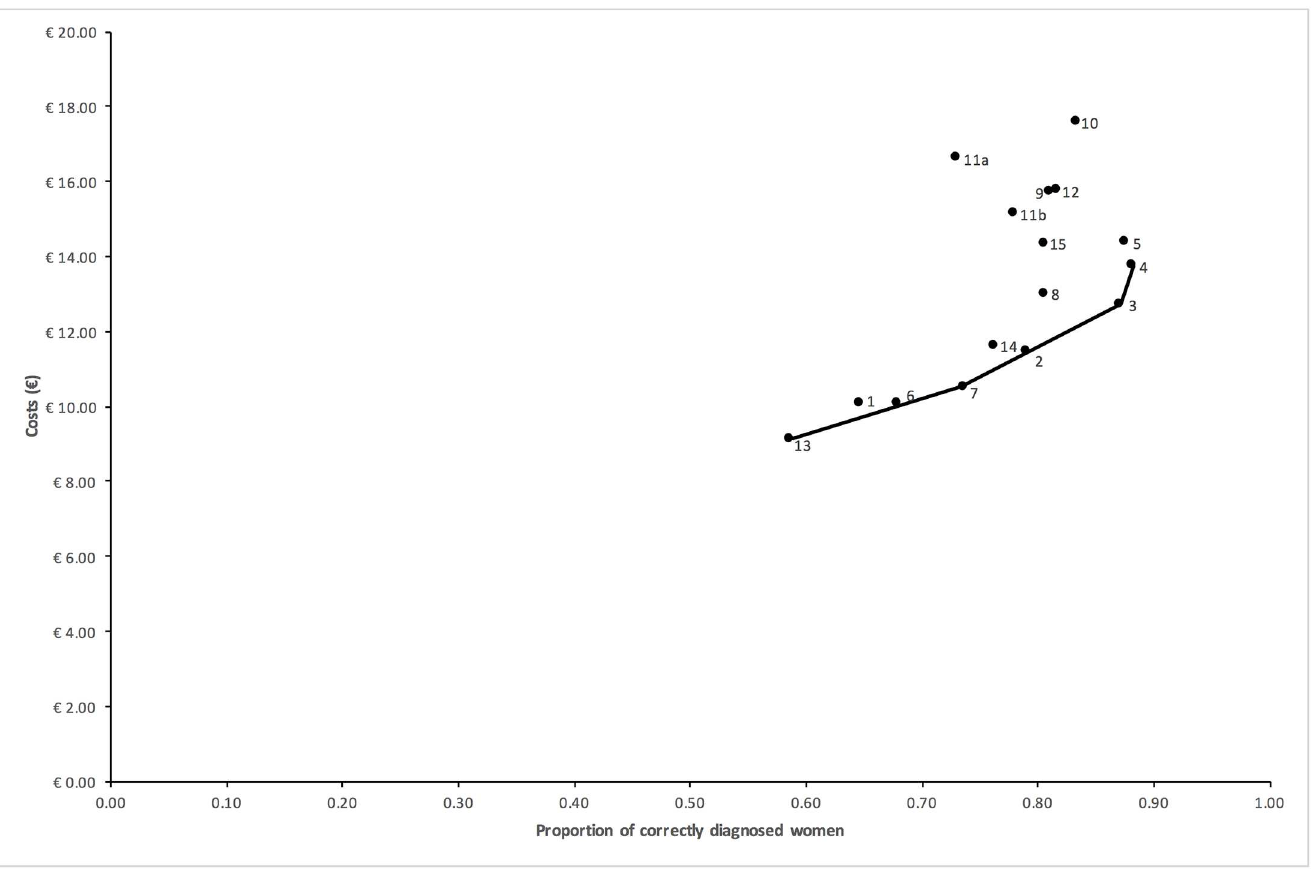
Fig 1. Cost-effectivenessplane. The cost-effectiveness plane shows for each strategy the expectedproportionof correctly classifiedwomen (x-axis) and expectedcosts (y-axis). By drawinga line betweenstrategies 13, 7, 3 and 4 (dominant strategies) the efficiency frontier is revealed.